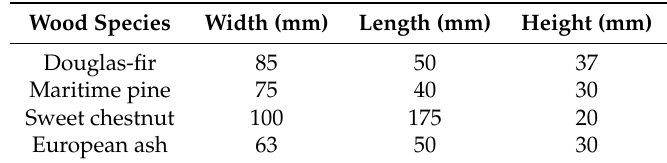
Table 2. Geometrical dimensions of wood blocks of different species used for the experimental electrical resistance measurement test. Wood Species Width (mm) Length (mm) Height (mm) Douglas-fir 85 50 37 Maritime pine 75 40 30 Sweet chestnut 100 175 20 European ash 63 50